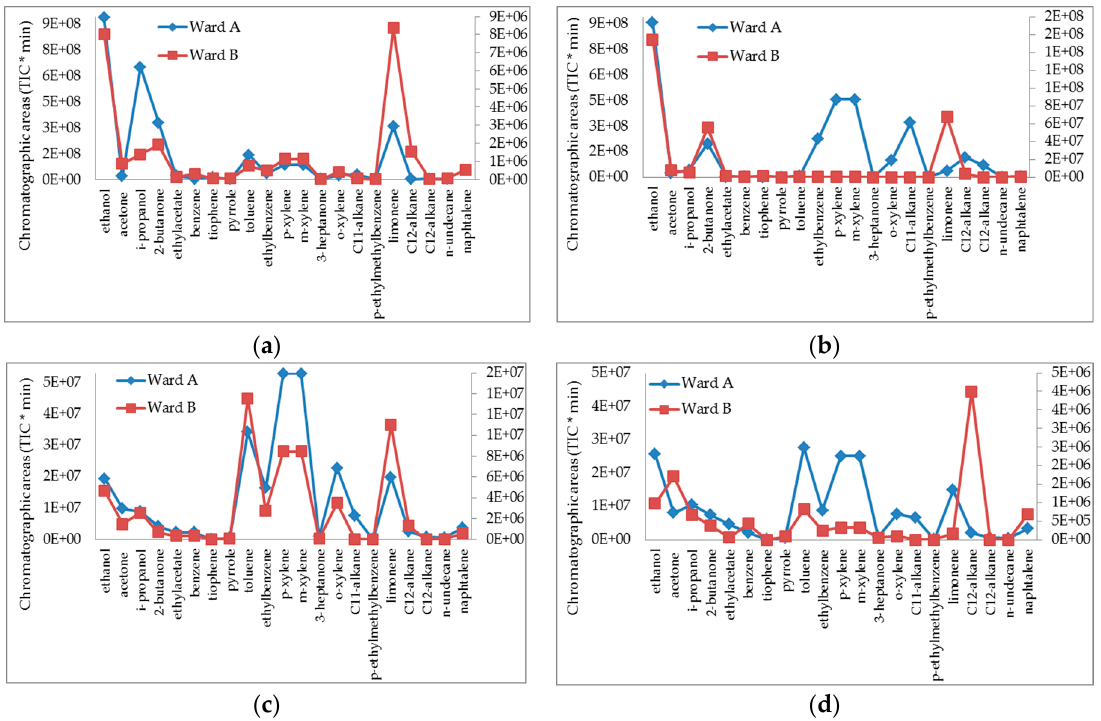
Figure 2. Chromatographic areas (TIC/min, total ion current per minute) of detected compounds: comparison between different sampling sites of the two anatomical pathology wards (A, B): ( a ) histology room; ( b ) processing room; ( c ) slide storage room; ( d ) secretariat room. The scale to the left refers to the blue line and the right one to the red line.